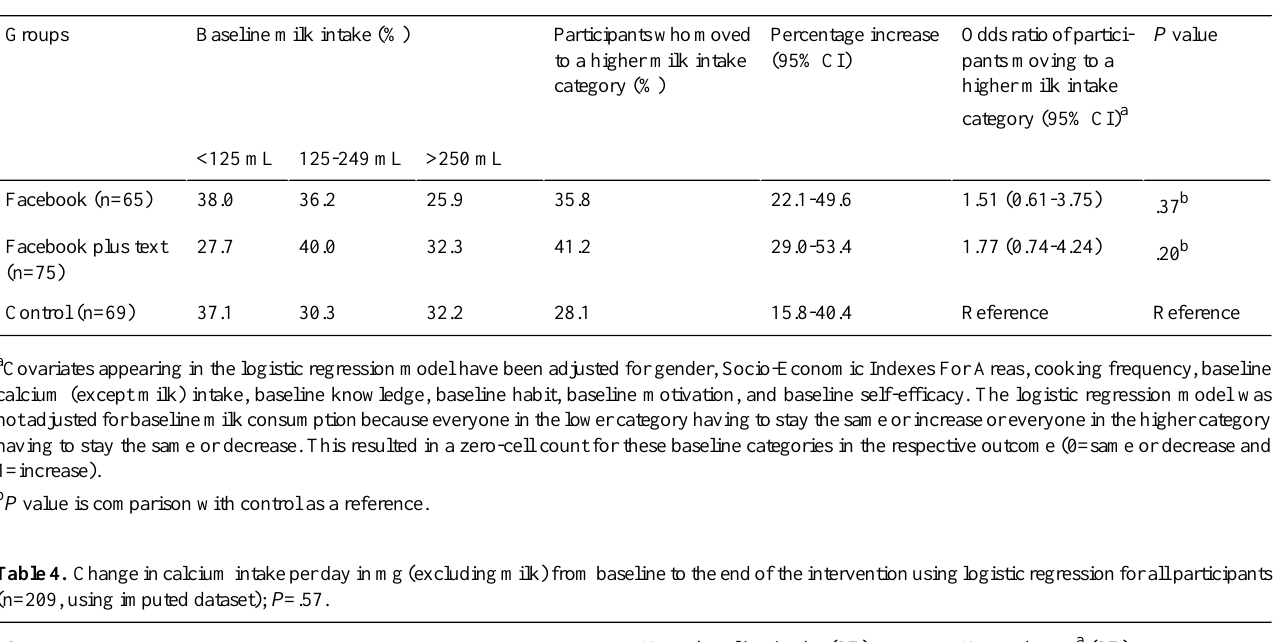
Table 3. Change in category of the amount of milk intake from baseline to the end of the intervention for all participants (n=209, using imputed dataset); overall P =.41.